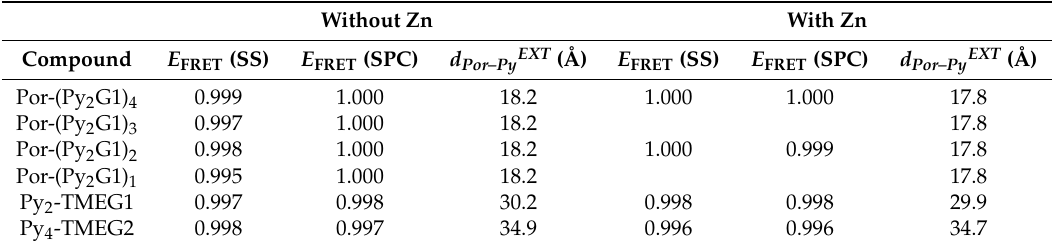
Table 3. FRET efficiency and d Por − PyEXT for porphyrinic constructs. Reprinted with permission from (Zaragoza-Gal á n, G., Fowler, M., Rein, R., Solladi é , N., Duhamel, J., & Rivera, E. (2014).